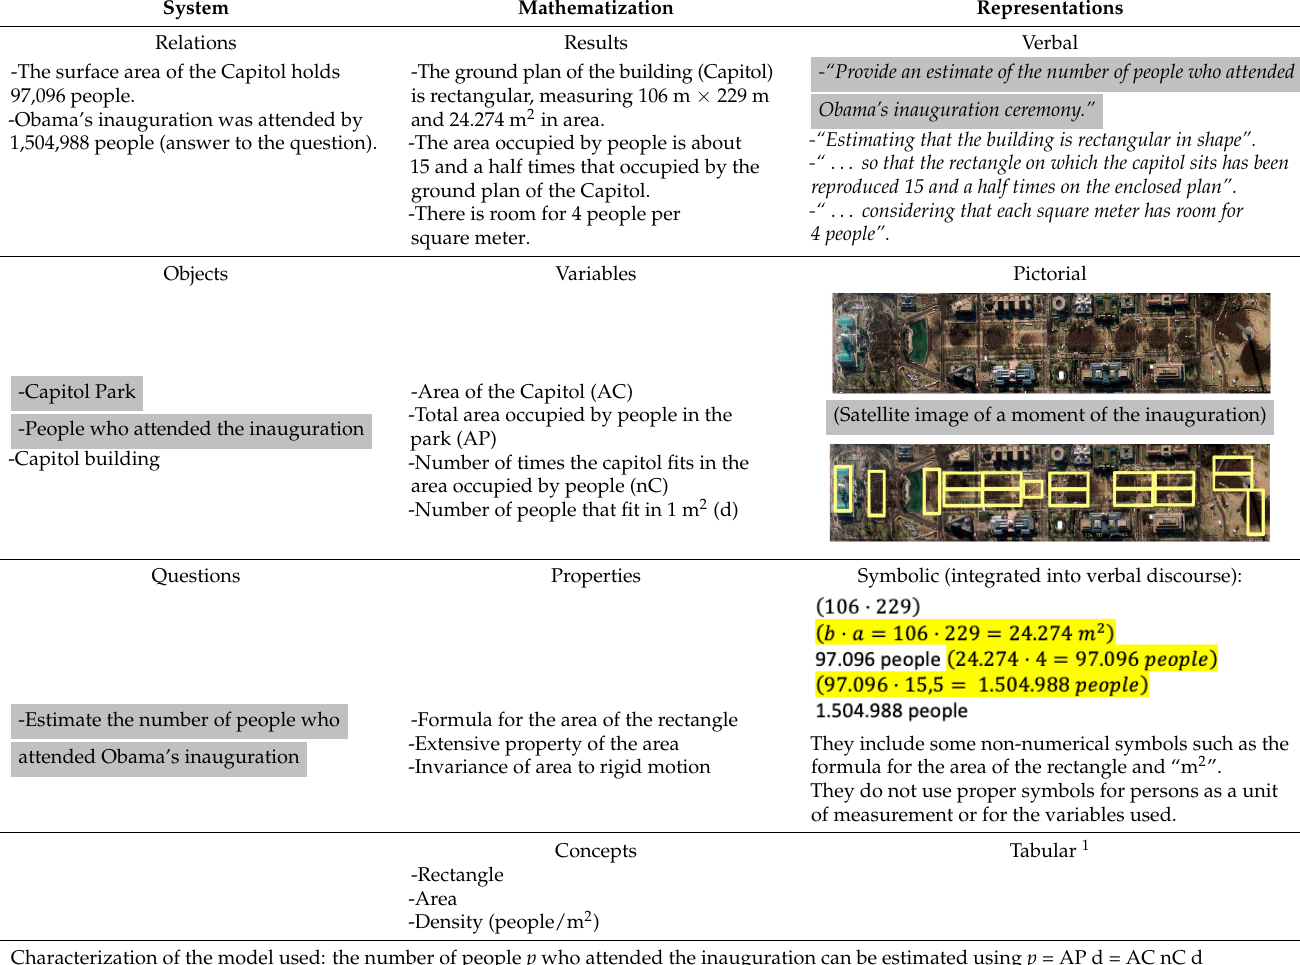
Table 4. Analysis of the written production for the task “the play center.” The elements shaded in gray were explicitly provided in the statement of the task (Source: prepared by the authors).